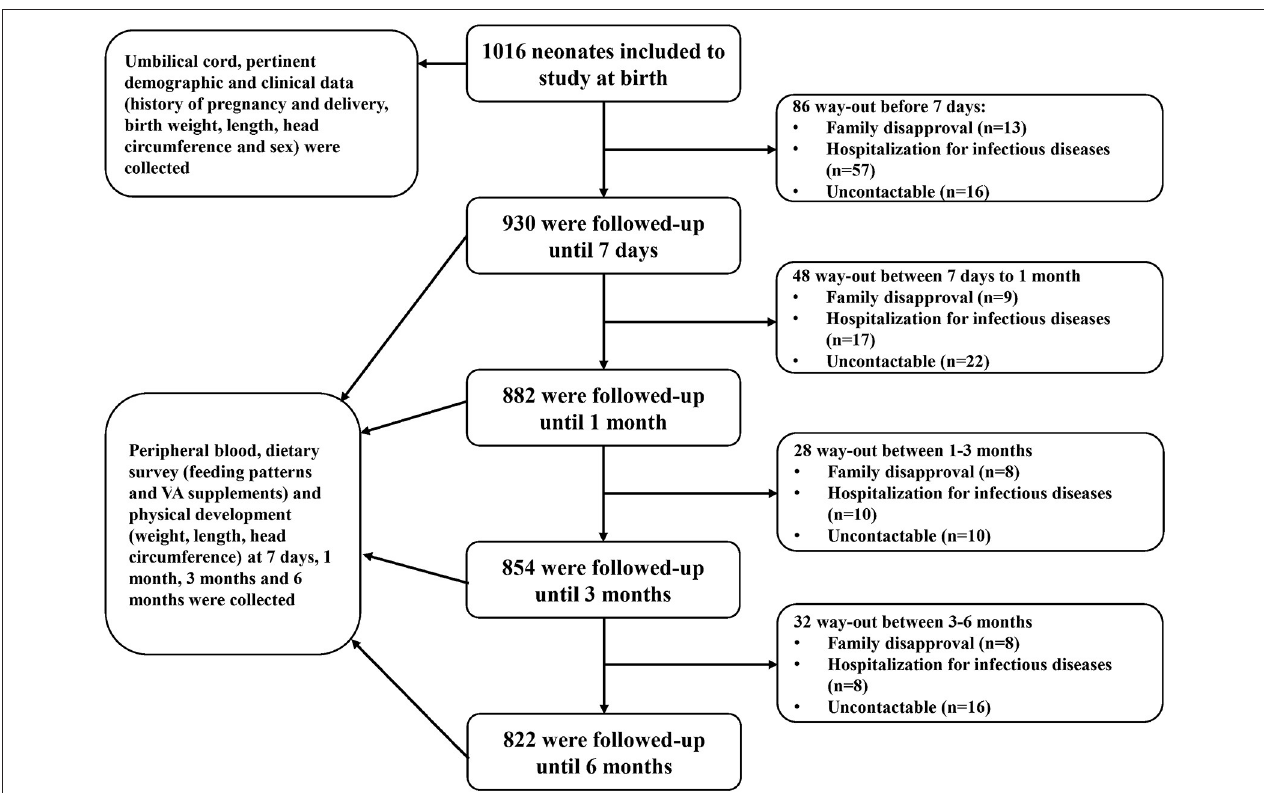
FIGURE 1 | Flowchart diagram of follow-up. Infants were enrolled from birth and were followed up at postnatal day 7 and postnatal months 1, 3, and 6. At birth, blood samples and pertinent demographic and clinical data were collected. During follow-up, blood samples and dietary survey and physical development data were